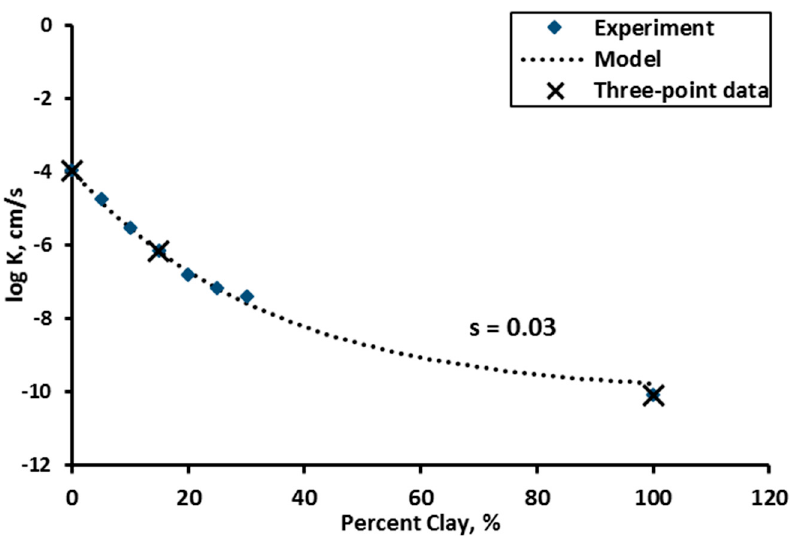
Figure 8. Experimental hydraulic conductivity values for bentonite-silt mixtures [26] at different bentonite content in comparison with fitted model results using the proposed model—Equation (1). The cross symbol is used to identify the data points used in the three-point method discussed in Section 3.5.